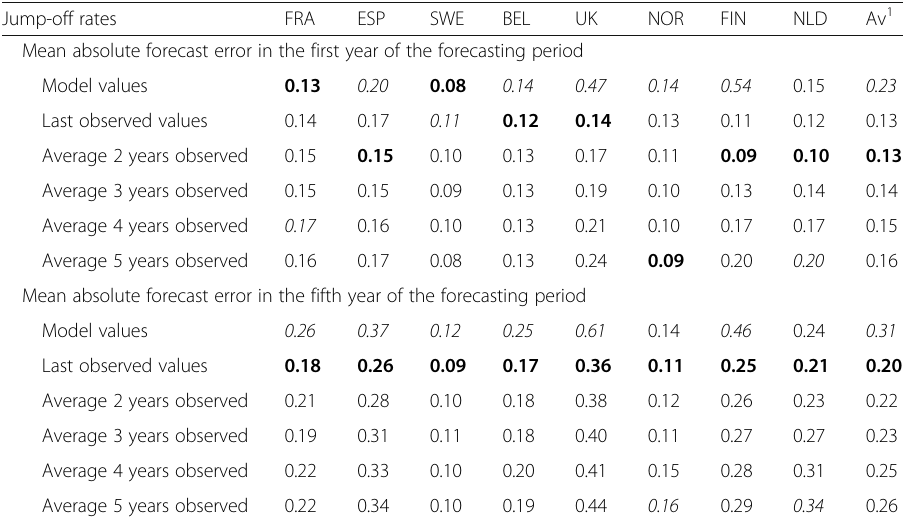
Table 8 Mean absolute forecast error (MAFE) of remaining life expectancy at age 65 for the first and fifth year in the forecasting period, and standard deviation (SD) of the increase/decrease of the life expectancy at age 65 in 2020 between ten successive forecasts, for six different choices of the jump-off rates applied to a Lee-Carter model, for eight countries, men (a) and women (b),